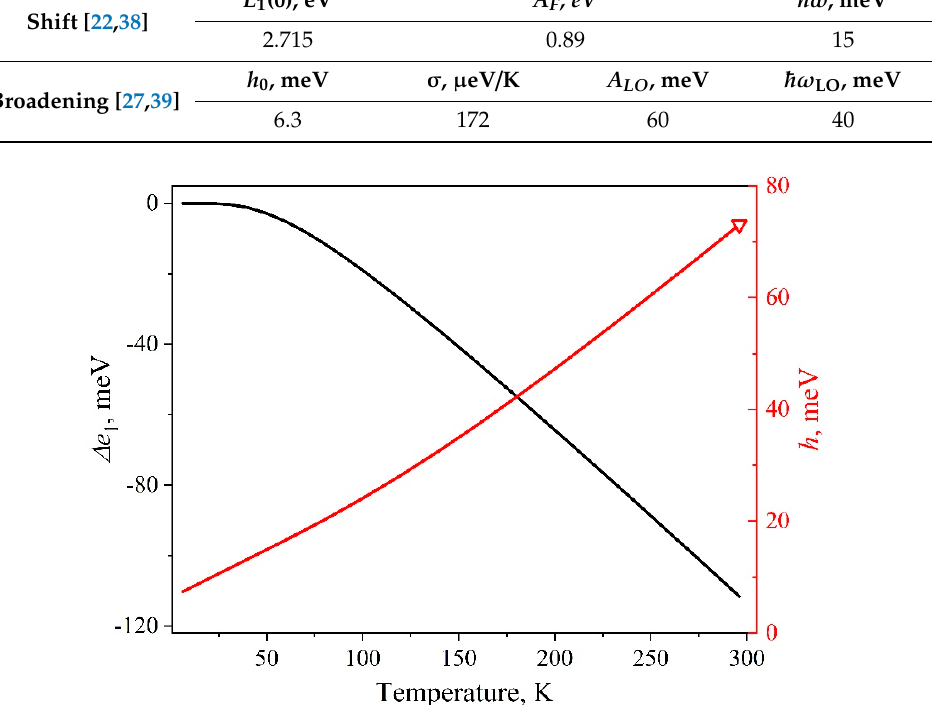
Table 1. Parameters of temperature evolution for exciton peak in InP / ZnS single nanocrystal. E 1 (0), eV A F , eV ¯ h ω , meV Shift [22,38]